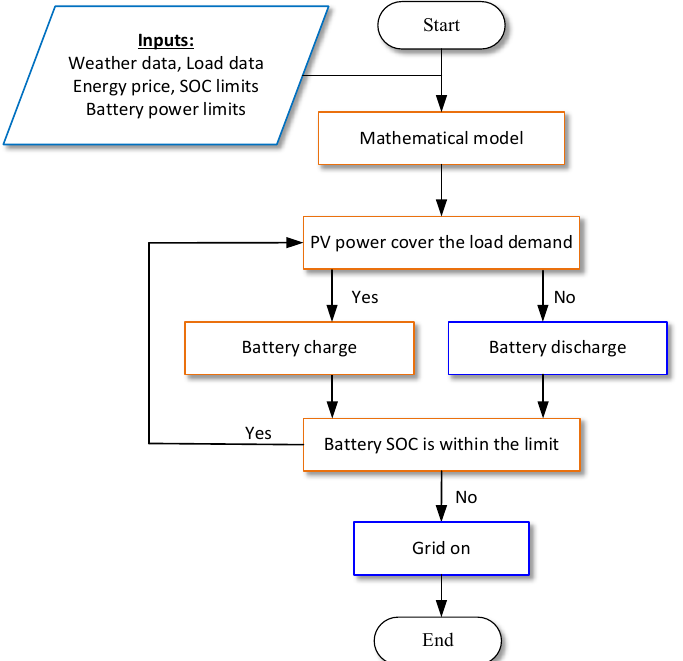
Figure 8. Flowchart of maximum self-consumption strategy.